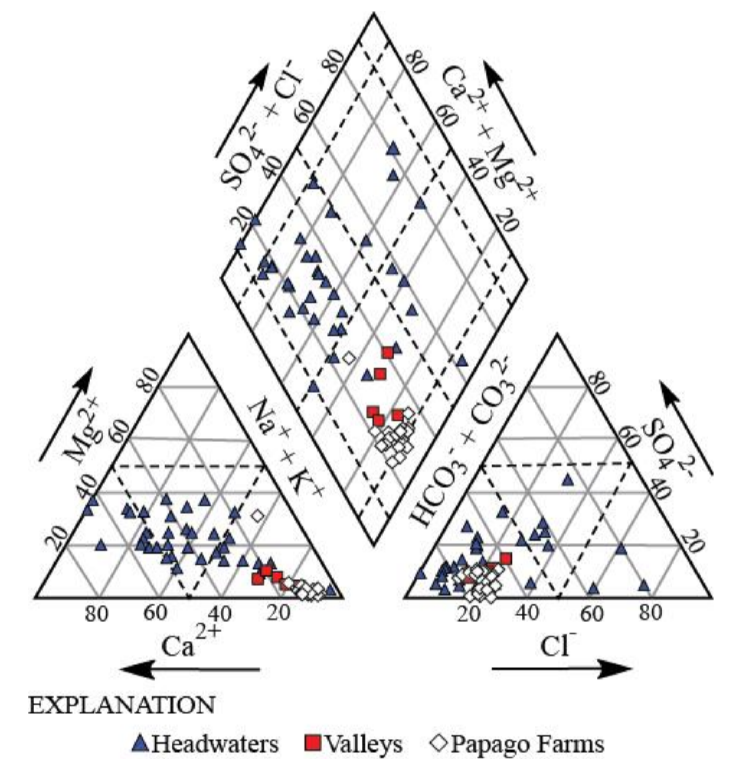
Figure 6. Piper Diagram showing data for groundwater samples along the Sonoyta River course. “Headwater” samples were collected near the Baboquivari Mountains, “Valleys” samples were collected along the floodplains downstream, and “Papago Farms” samples were collected within the irrigated fields of the Tohono O’odham Nation (see Figure 1 for location). Data from Water Quality Portal